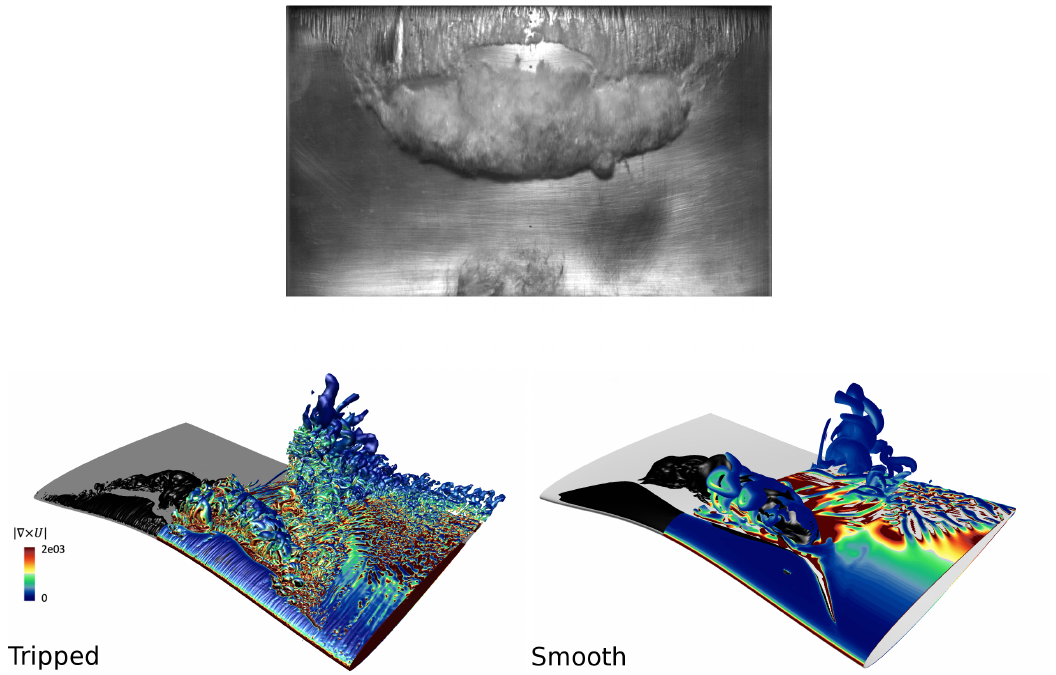
Figure 8. Isometric view of the numerical results of Figure